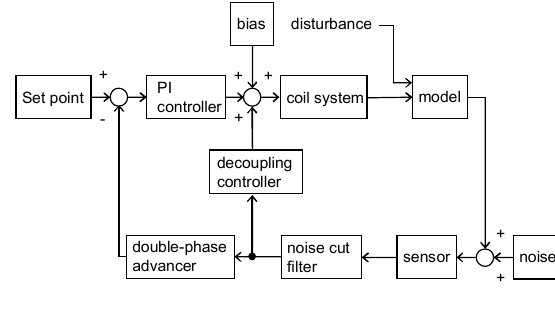
Figure 2. Diagram of 1-m